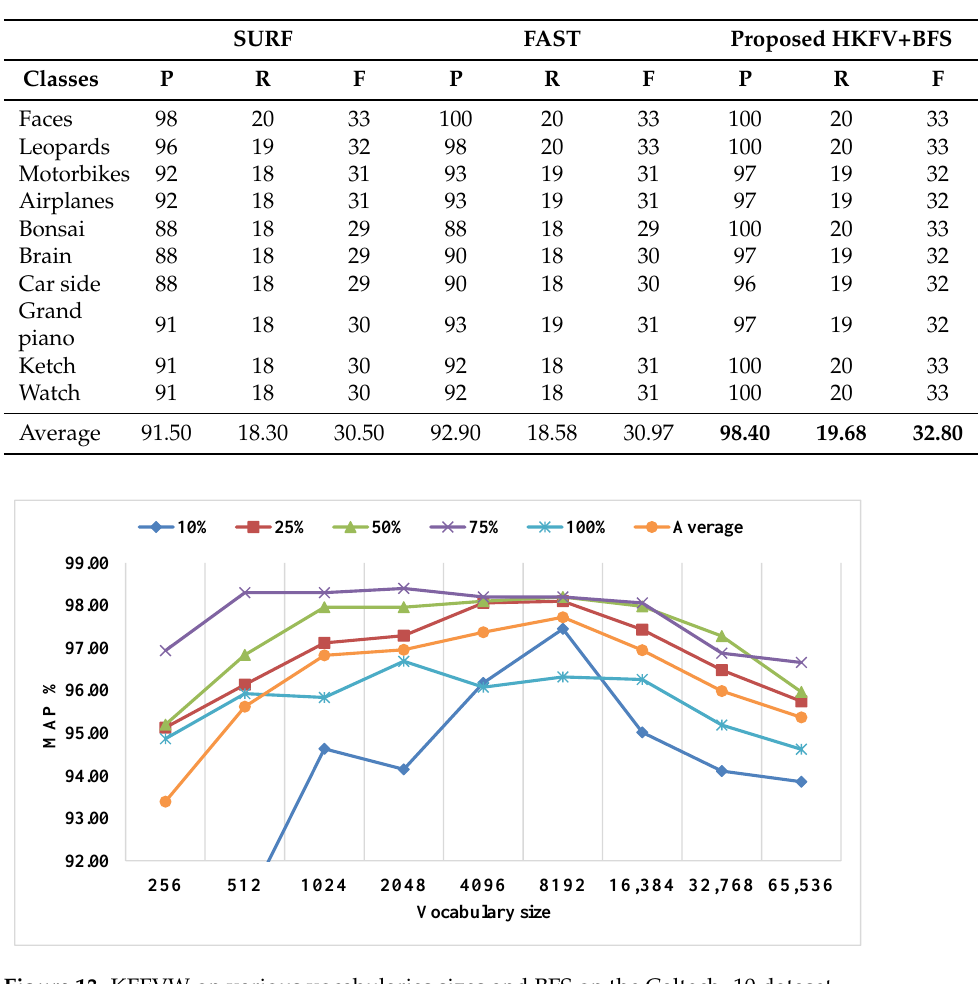
Figure 13. KFFVW on various vocabularies sizes and BFS on the Caltech -10